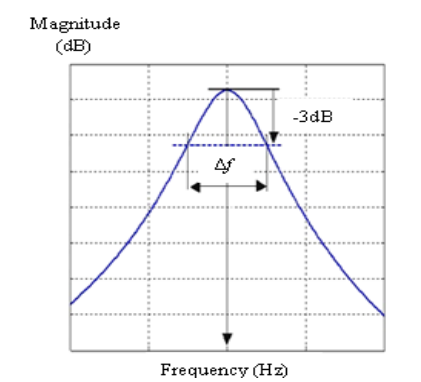
Figure 4. The half-power bandwidth